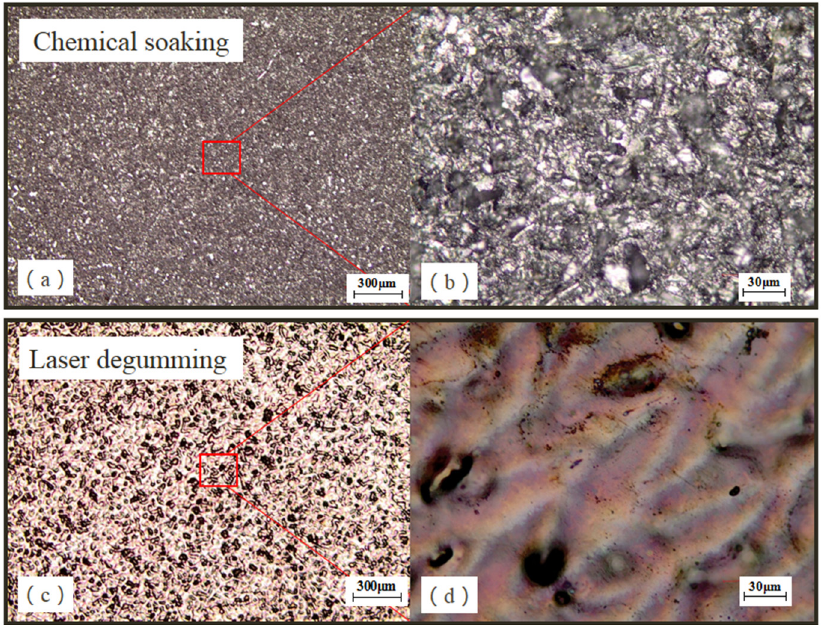
Figure 3. Sample topography done by chemical soaking ( a , b ) and laser degumming ( c , d ). Herein, ( a , c ) and ( b , d ) was detected by 50× and 500× optical microscopy, respectively. To get insight into the sample topography variation, the results measured by white light interferometer are presented in Figure 4. The sample surface after laser processing was a little smoother than after chemical soaking, as the values of Sa (the average of the height difference) and Sq (the root mean square of the height difference) were lower. On the other hand, the Sz value (the sum of the maximum peak height and valley depth) of